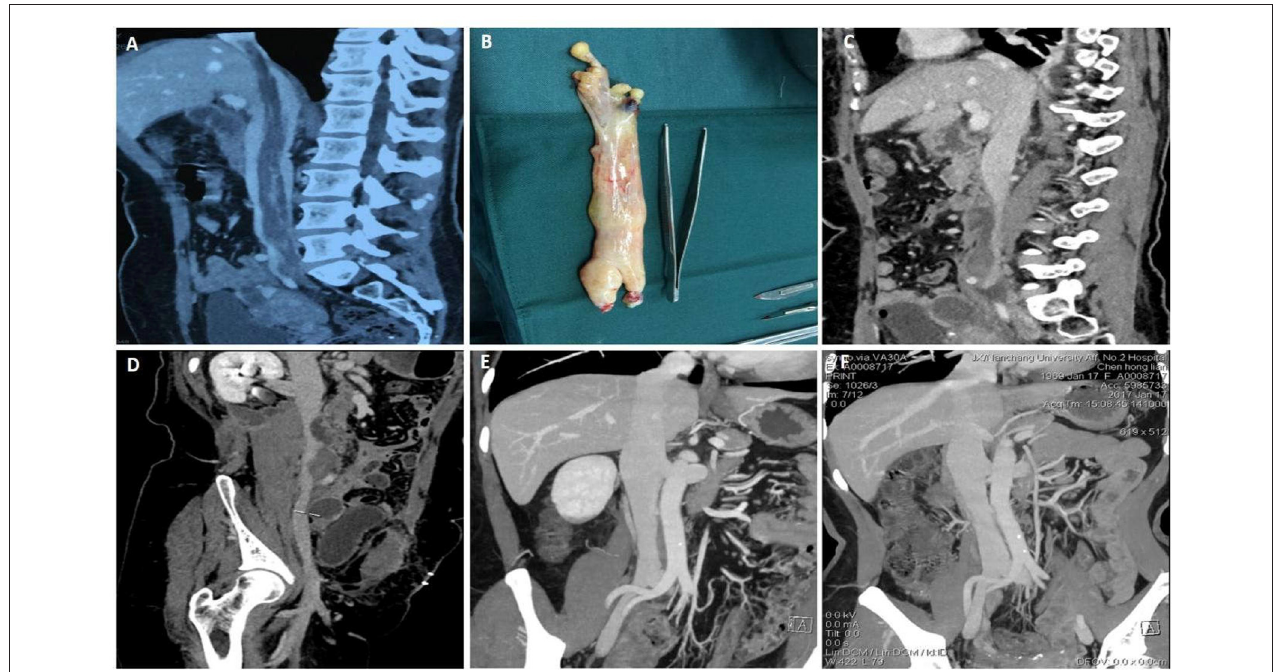
FIGURE 1 | Data of case 1 before, during, and during follow-up. (A) Preoperative computed tomography venography (CTV) confirmed a mass that extended from the right internal iliac vein to the proximal inferior vena cava and extended into the right atrium. (B) An intact yellow mass was removed from the right atrium and proximal to the inferior vena cava. (C,D) Seven days after surgery, CTV confirmed that the mass was removed and the inferior vena cava was unobstructed. (E,F) Six-month follow-up CTV and 12-month follow-up CTV revealed no residual mass or recurrence and the prognosis was